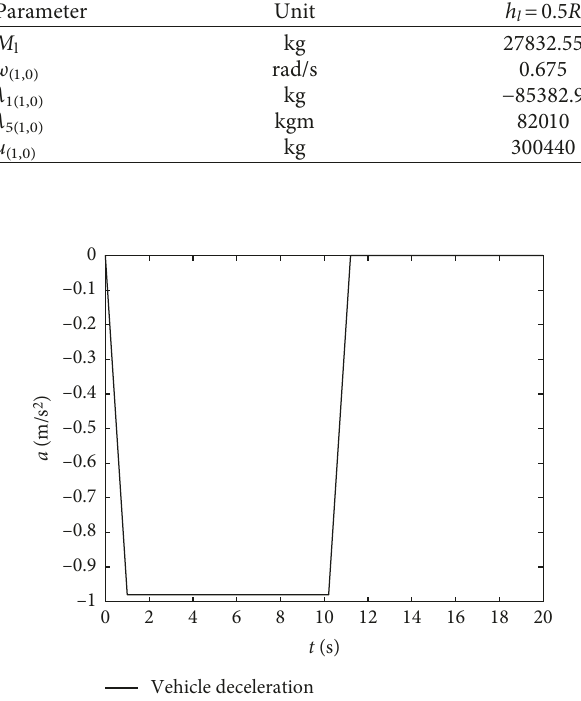
Figure 11: Deceleration during vehicle braking.